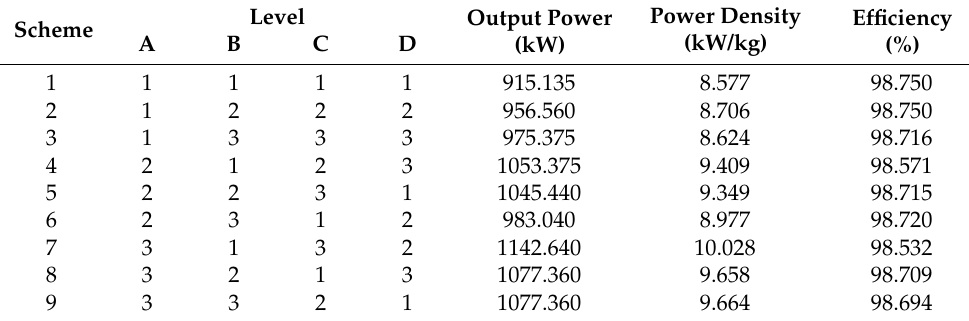
Table 7. Orthogonal table and optimization results.